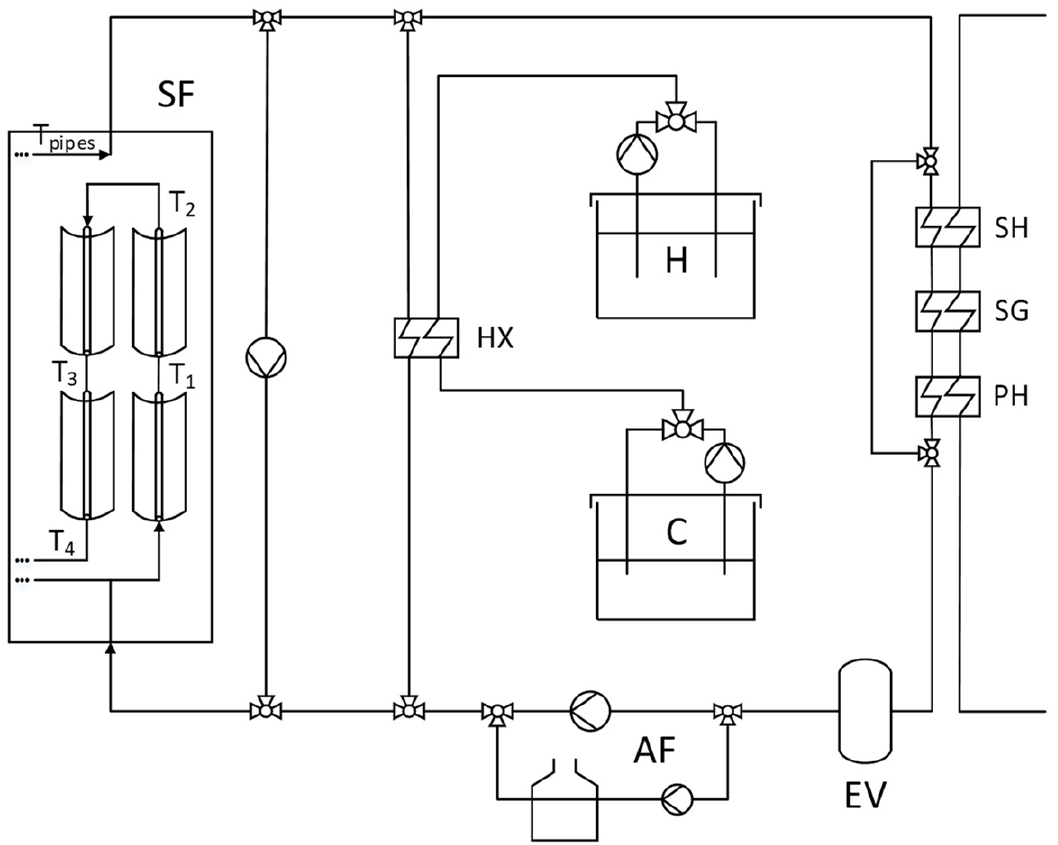
Figure 1. Scheme of the solar field (adapted from [32]). Each loop consists of 4 SCAs in series formed by 12 SCEs, each one with 36 HCEs. The field is composed of 156 loops in parallel. SF = solar field; HX = heat exchanger; H = hot tank; C = cold tank; AF = anti-freeze system; EV = expansion vessel.